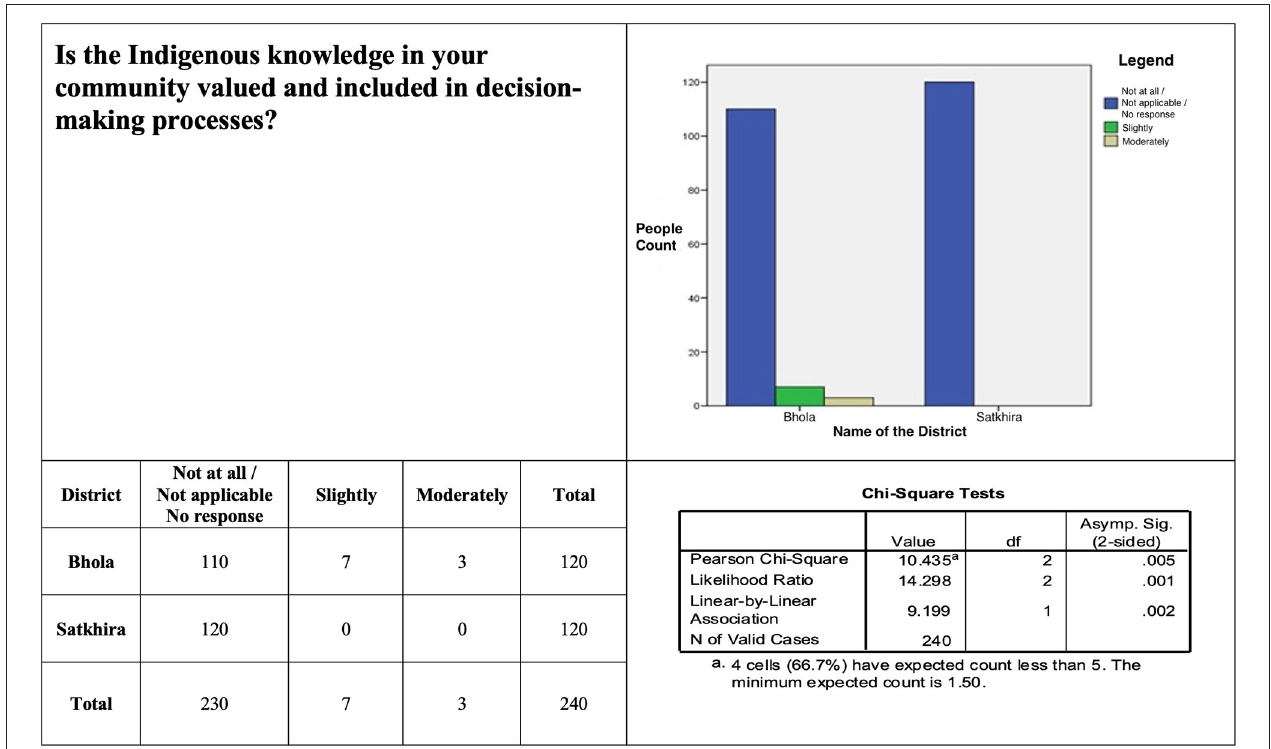
FIGURE 7 | Cross Table Analysis and Chi-Square Tests on participant’s perception of Indigenous knowledge is valued in decision-making, by